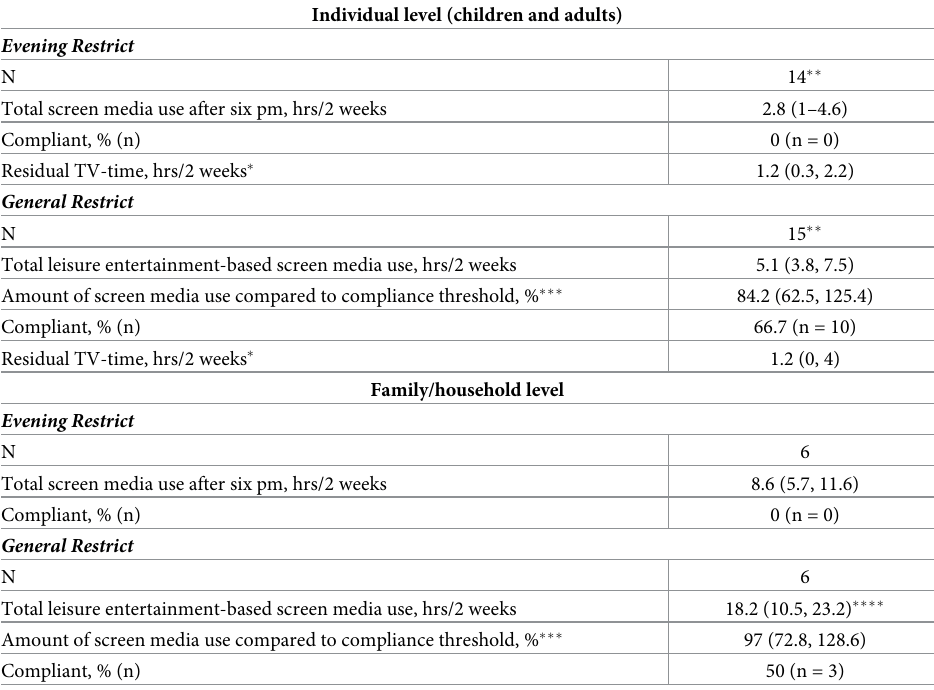
Table 2. Overview of screen media use and compliance rates during two-week interventions. Individual level (children and